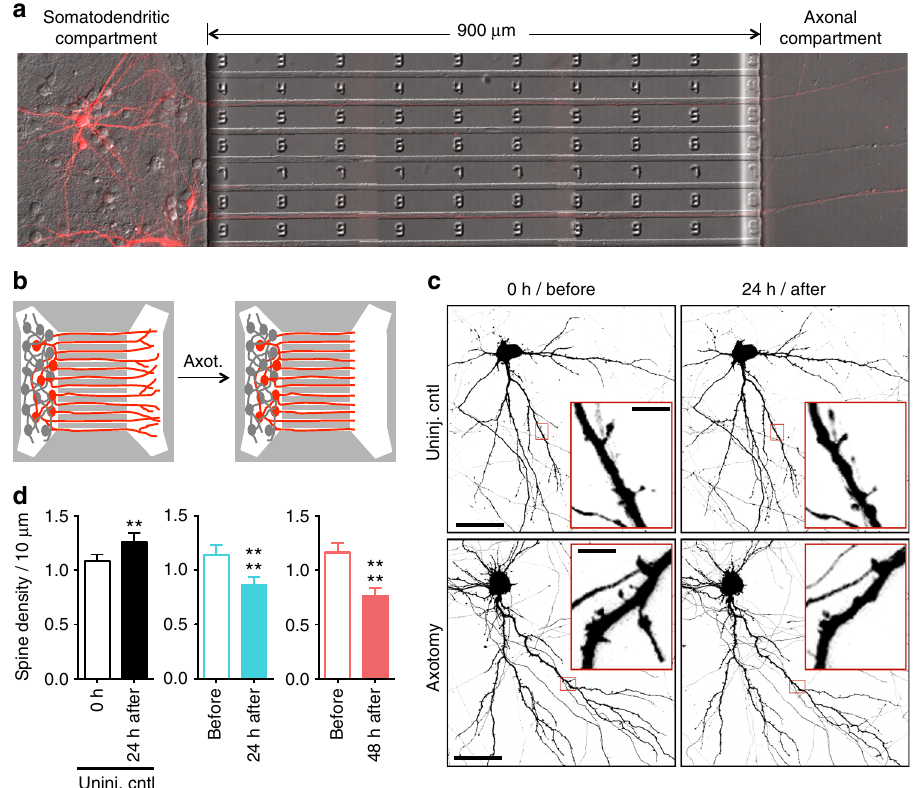
Fig. 1 Dendritic spine density of pyramidal neurons within micro fl uidic chambers before and after axotomy. a 14 DIV rat hippocampal neurons cultured within a micro fl uidic chamber. Pyramidal neurons were retrogradely labeled using a G-deleted mCherry rabies virus added exclusively to the axonal compartment. b Cartoon illustration of in vitro axotomy (Axot.) within micro fl uidic chambers to selectively axotomize a subset of labeled neurons ( red ) that extend axons through the microgroove region. Axons of neighboring uncut neurons ( gray ) remain within the somatodendritic compartment. c Representative images of mCherry-labeled neurons and dendritic segments (inverted fl uorescence) from repeated live imaging of uninjured control chambers (Uninj. cntl) and axotomized chambers. Axotomized chambers were imaged before axotomy on 13 DIV (before) and uninjured control chambers were also imaged on 13 DIV (0 h); both conditions were then imaged at 14 DIV (24 h after). Image and inset scale bars , 50 and 5 µ m, respectively. d Quanti fi cation of spine density illustrated in c . Uninj. cntl : n = 20 dendrites; 5 neurons; 3 chambers over 3 experiments; #spines/TDL: 315/2698 µ m (0 h), 388/2737 µ m (24 h after). Axot .: n = 26 dendrites; 5 neurons; #spines/TDL: 405/3569 µ m (before), 274/2998 µ m (24 h after), and 229/2821 µ m (48 h after). 3 chambers over 3 experiments. TDL: total dendritic length. Paired two-tailed t -test. ** p < 0.01, **** p < 0.0001. Error bars ,